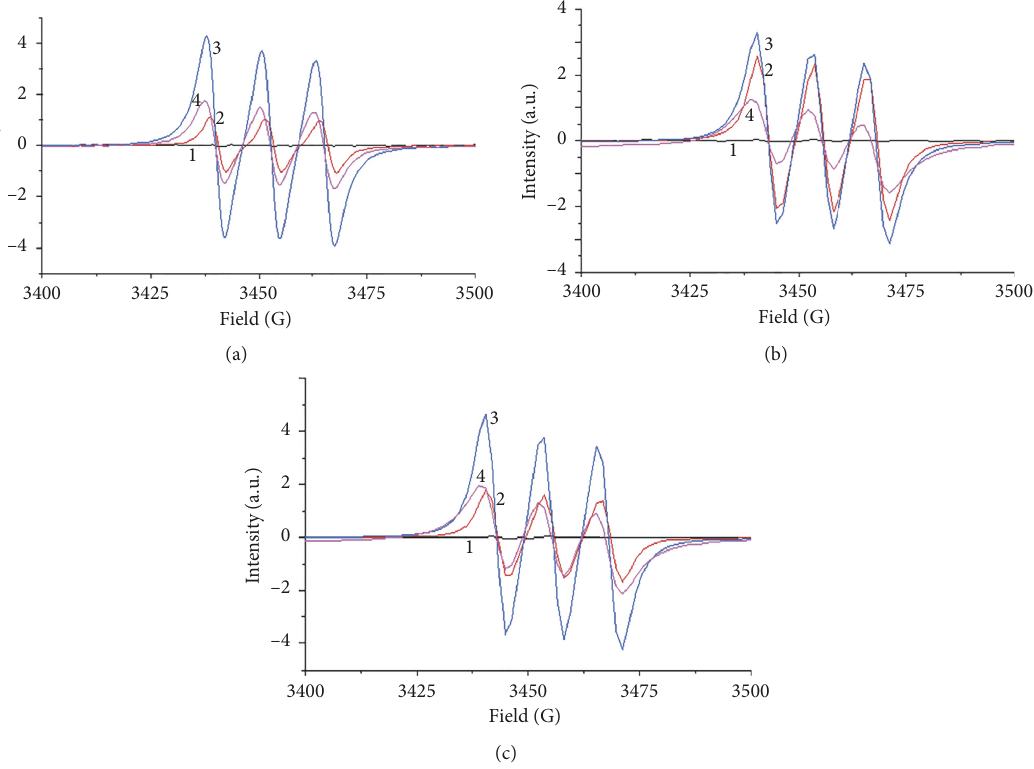
Figure 5: EPR spectra of [RuCl photoirradiation; 2: 15s; 3: 30s; 4:5 min).